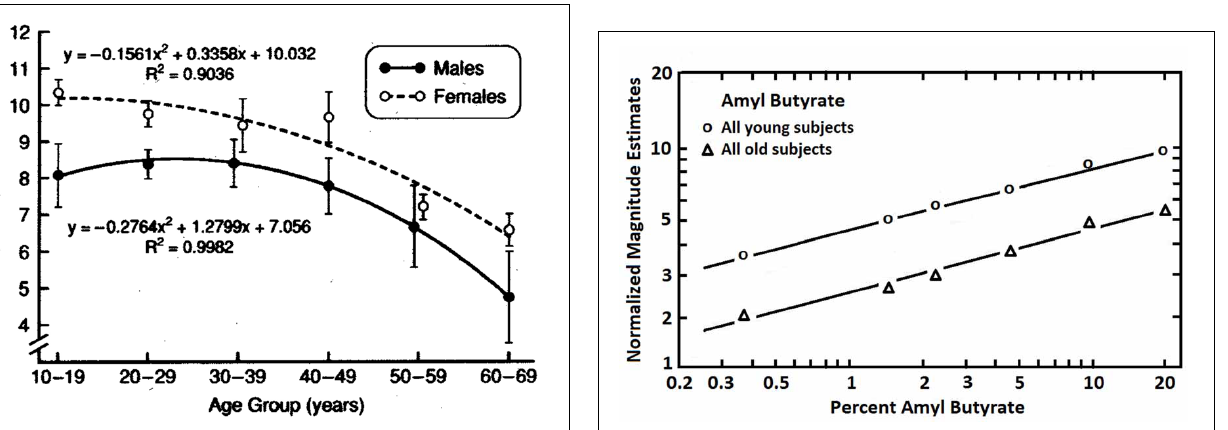
FIGURE 6 | Test scores for men and women on a 12-item odor discrimination/memory test as a function of age. Note age-related decline in performance and the fact that women outperform men at all ages. Data are collapsed over 0-, 30- and 60-s delay intervals. From Choudhury et al. (2003), with permission. Copyright©2003, Oxford University Press.